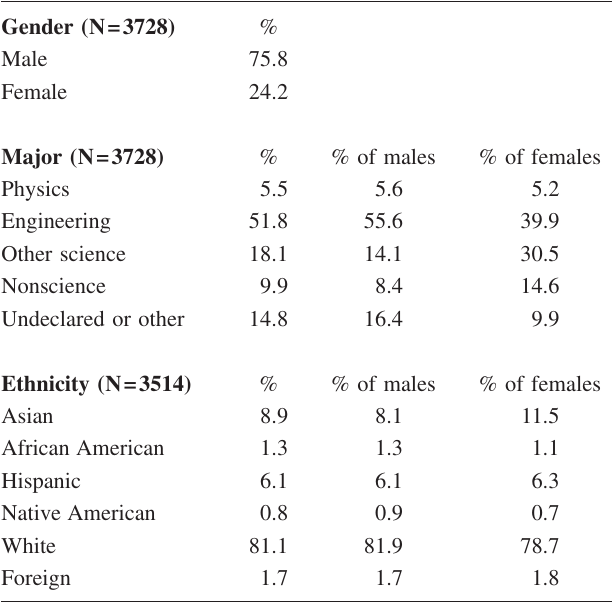
TABLE I. Frequencies for gender, student declared major, and ethnicity for all students in the study, that is, students who enrolled in introductory physics between Spring 2004 and Spring